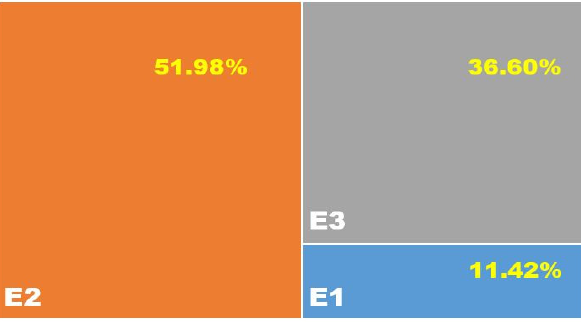
Figure 3. Percentage of presence by type of element.